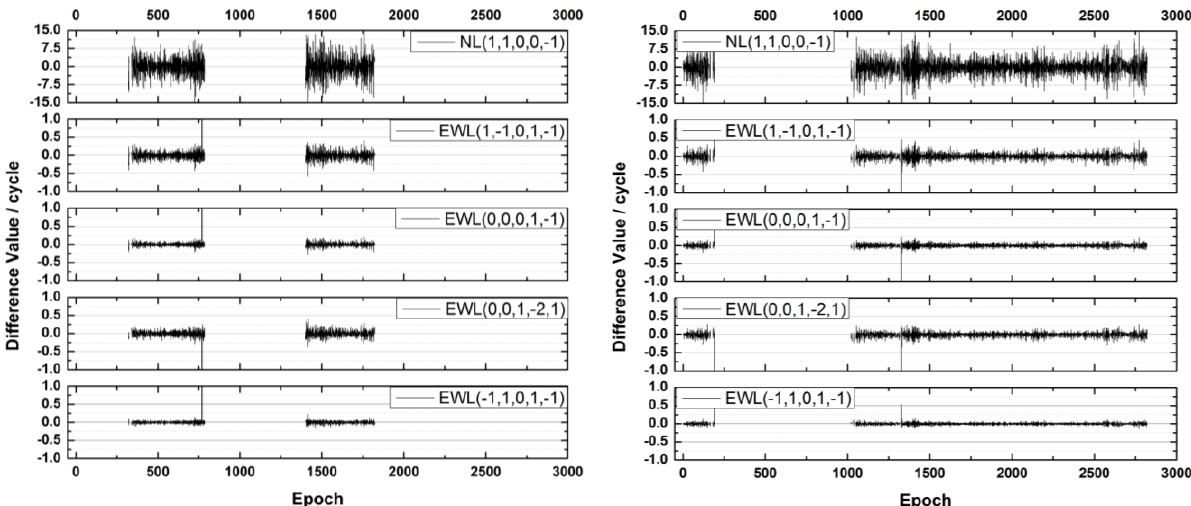
Figure 4. Combination ambiguity difference of satellite C34 and C40 between adjacent epoch for BDS-3 five